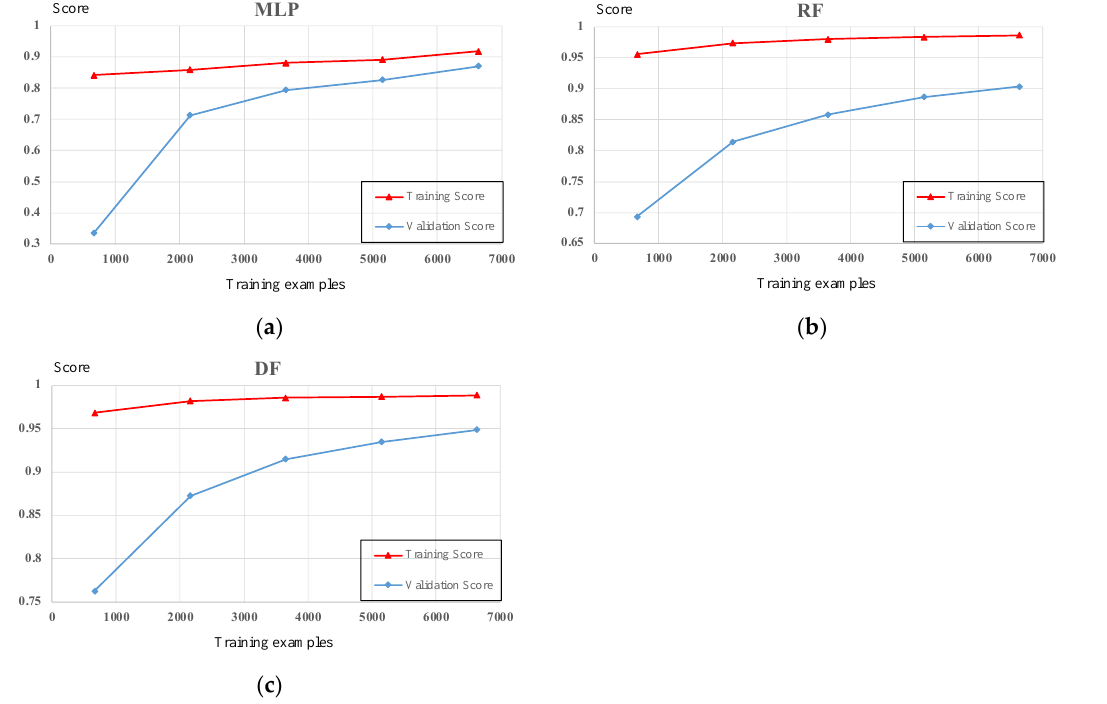
Figure 7. Learning curves of MLP, RF, and DF. ( a ) Learning curves of MLP; ( b ) Learning curves of RF; ( c ) Learning curves of DF.